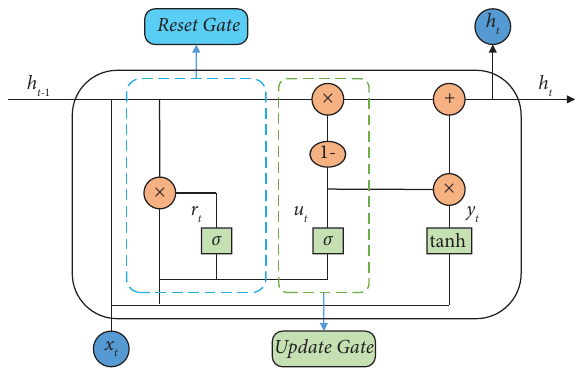
Figure 2: Te structure of